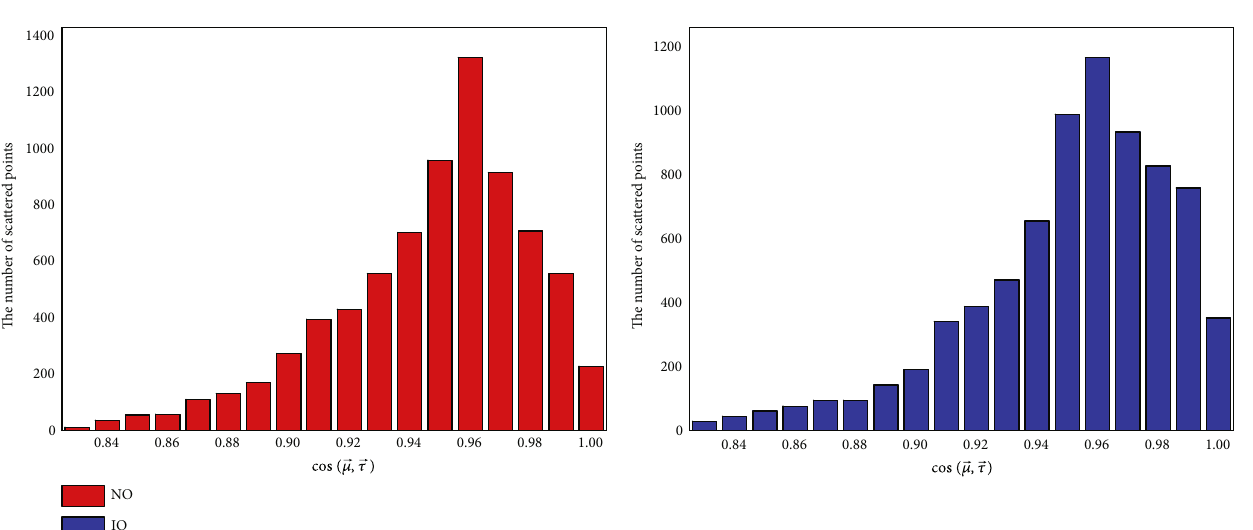
Figure 3: The number of scattered points corresponding to a series of small intervals of cos ð μ ! , τ ! Þ in Figure 2. Red: NO case. Blue: IO